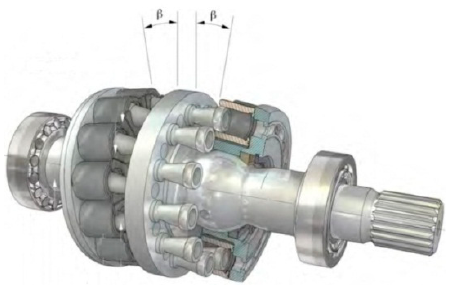
Figure 7. An HFPE-based machine–liquid hybrid system [16].